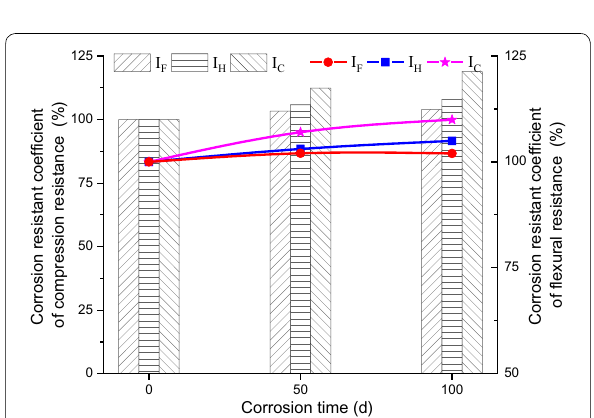
Fig. 5 Effect on strength of C30 concrete caused by three corrosion methods.